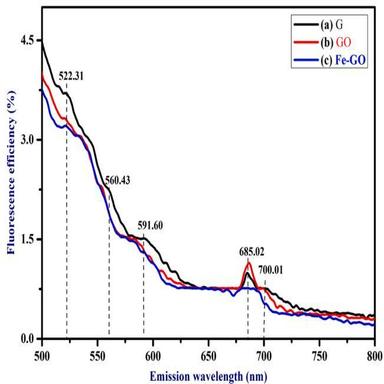
Steady-State Emission Spectra of Graphite (G), Graphene Oxide (GO), and the Fe-GO Nanocomposite at λexc = 458 nm.